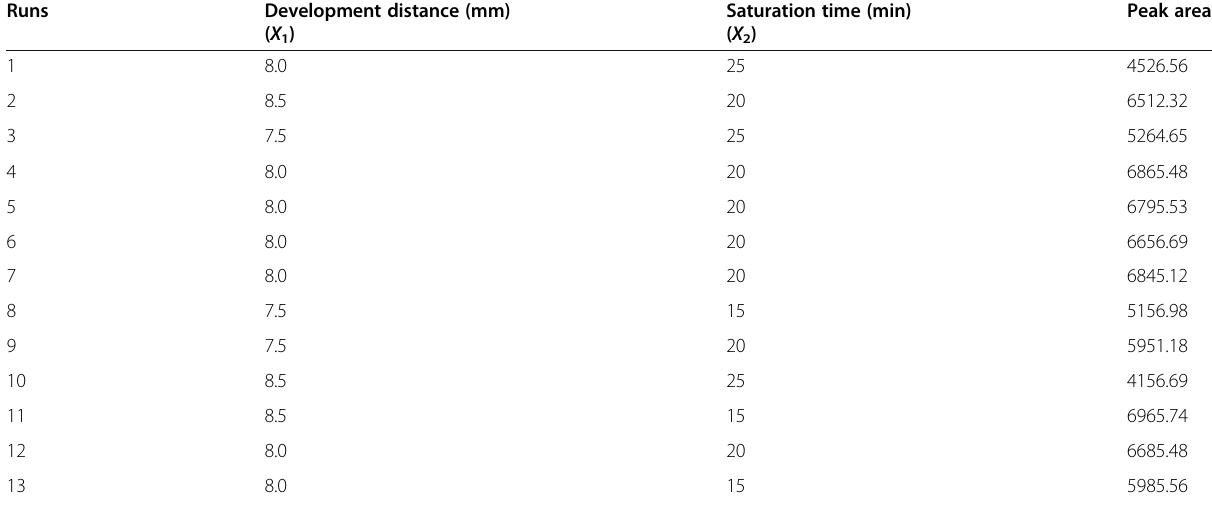
Table 3 Face-centered CCD matrix with two independent variables studied accompanied by results marked